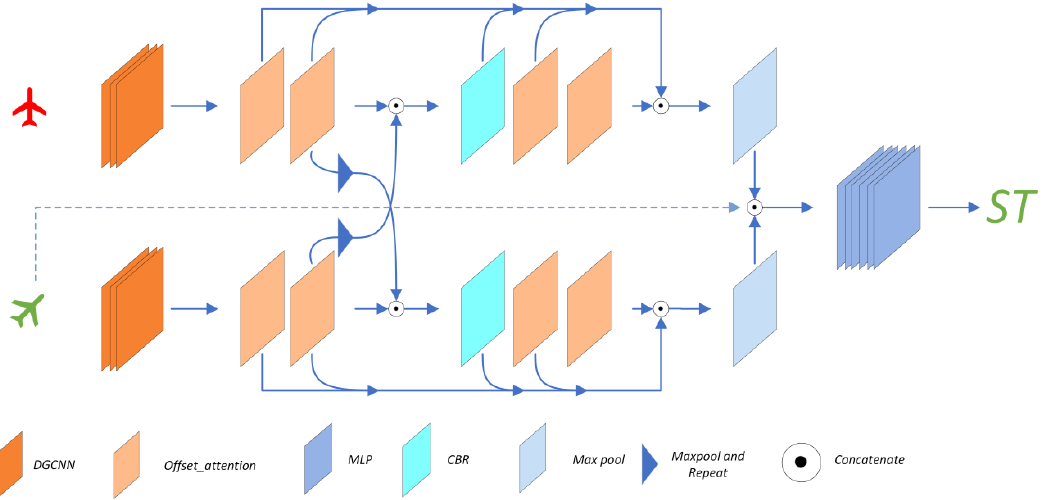
Figure 1. Network architecture of DOPNet, including DGCNN, cascading OA, feature interaction module, and MLP.